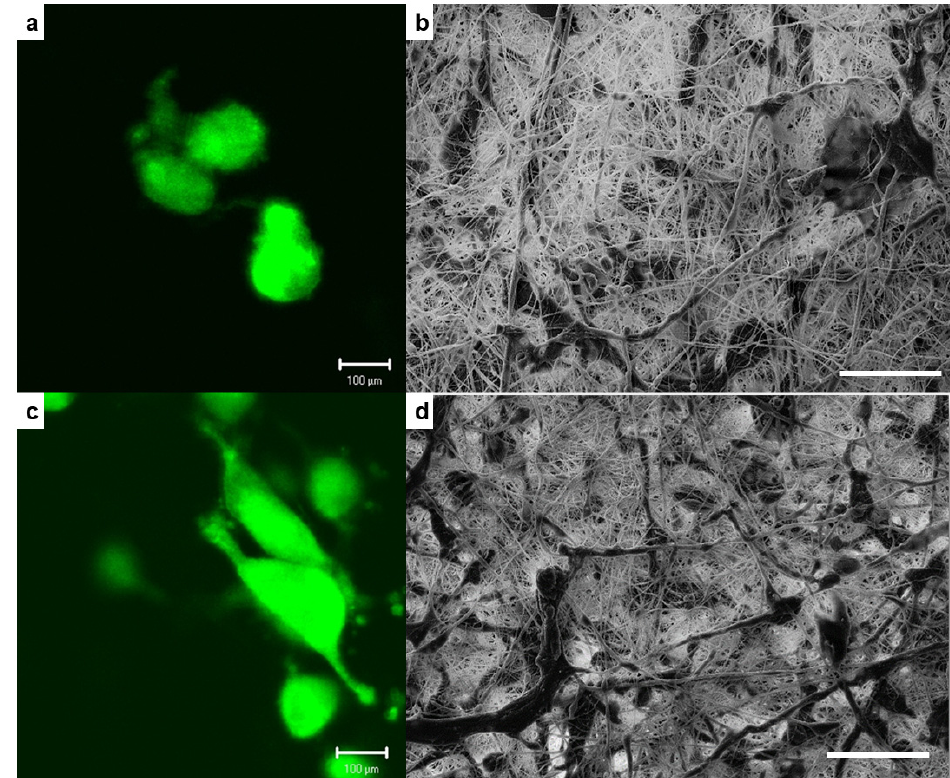
Figure 5. Representative fluorescence images of the cellular morphology and SEM micrographs of the spreading pattern interaction of hFOB cells cultured onto PLA fiber scaffold ( a , b ) and PLA/0.5 g ZrO 2 scaffolds ( c , d ) after 24 h of culture. Scale bar on SEM images = 100 µm .